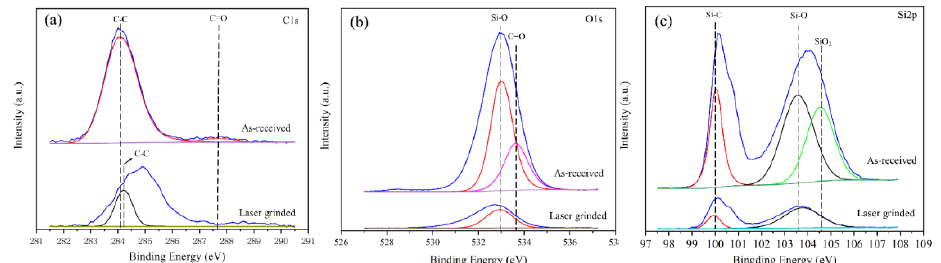
Figure 5. XPS spectra of the as-received and laser polished surface, which correspond to ( a – c ) result of curve fitting of C1s, O1s, and Si2p with bulk single crystal silicon surfaces (The XPS curves have been extracted from raw data after measurement and proceeded by standard analyses via Avantage software 5.967 (Thermo Fisher Scientific, Waltham, MA, USA)).